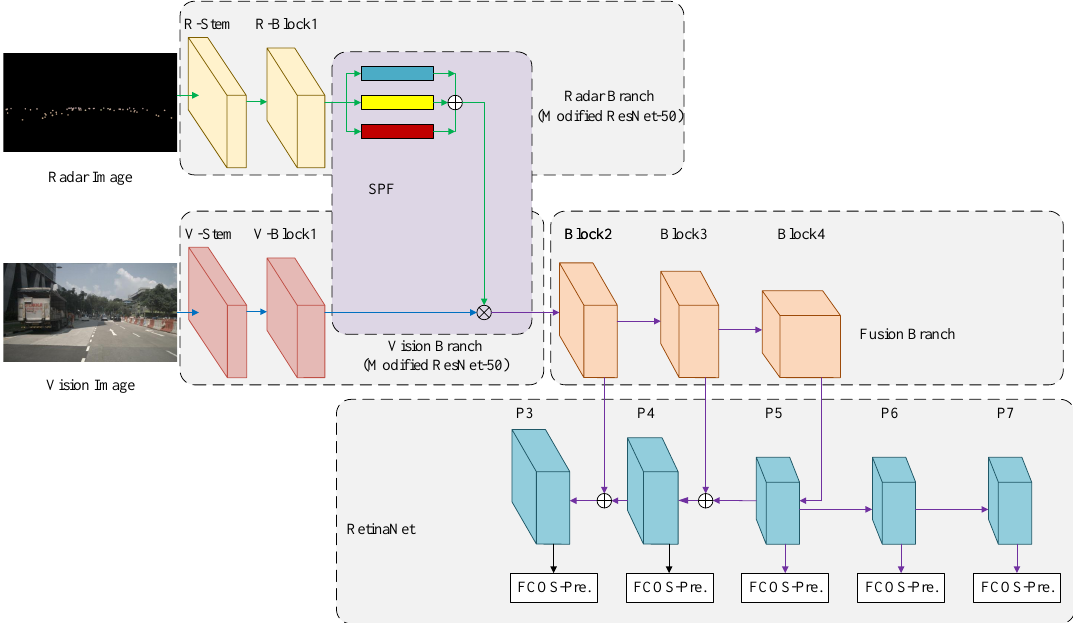
Figure 6. The proposed spatial attention fusion-based fully convolutional one-stage network (SAF-FCOS) for obstacle detection. In addition, the FCOS-Pre. block stands for the prediction head used in FCOS detection framework. The P3 stands for Phase